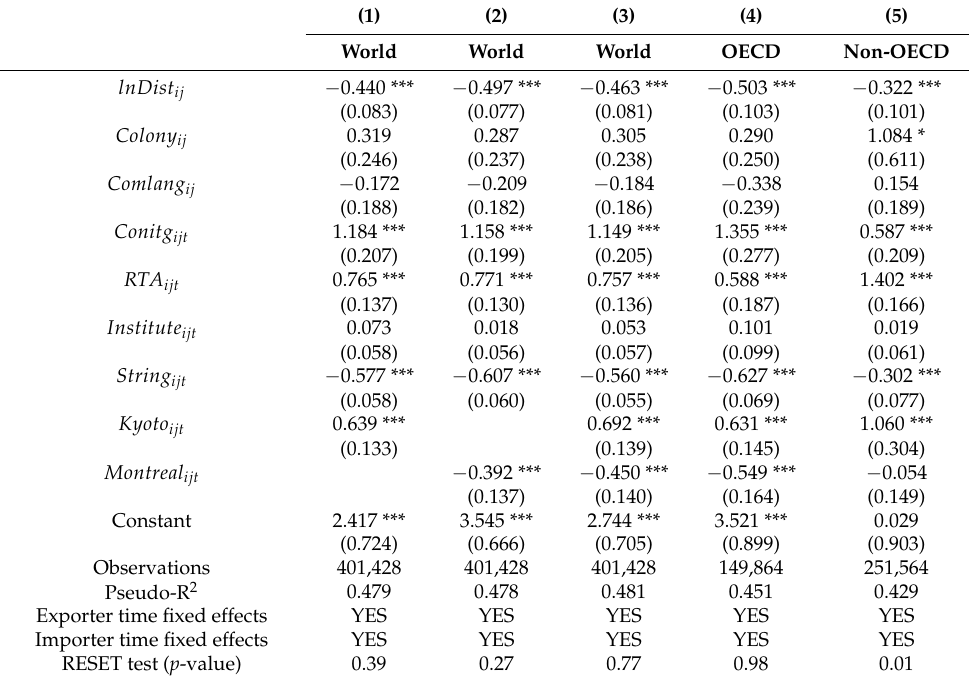
Table 5. PPML HDFE Estimation Results: Agreements Related Climate